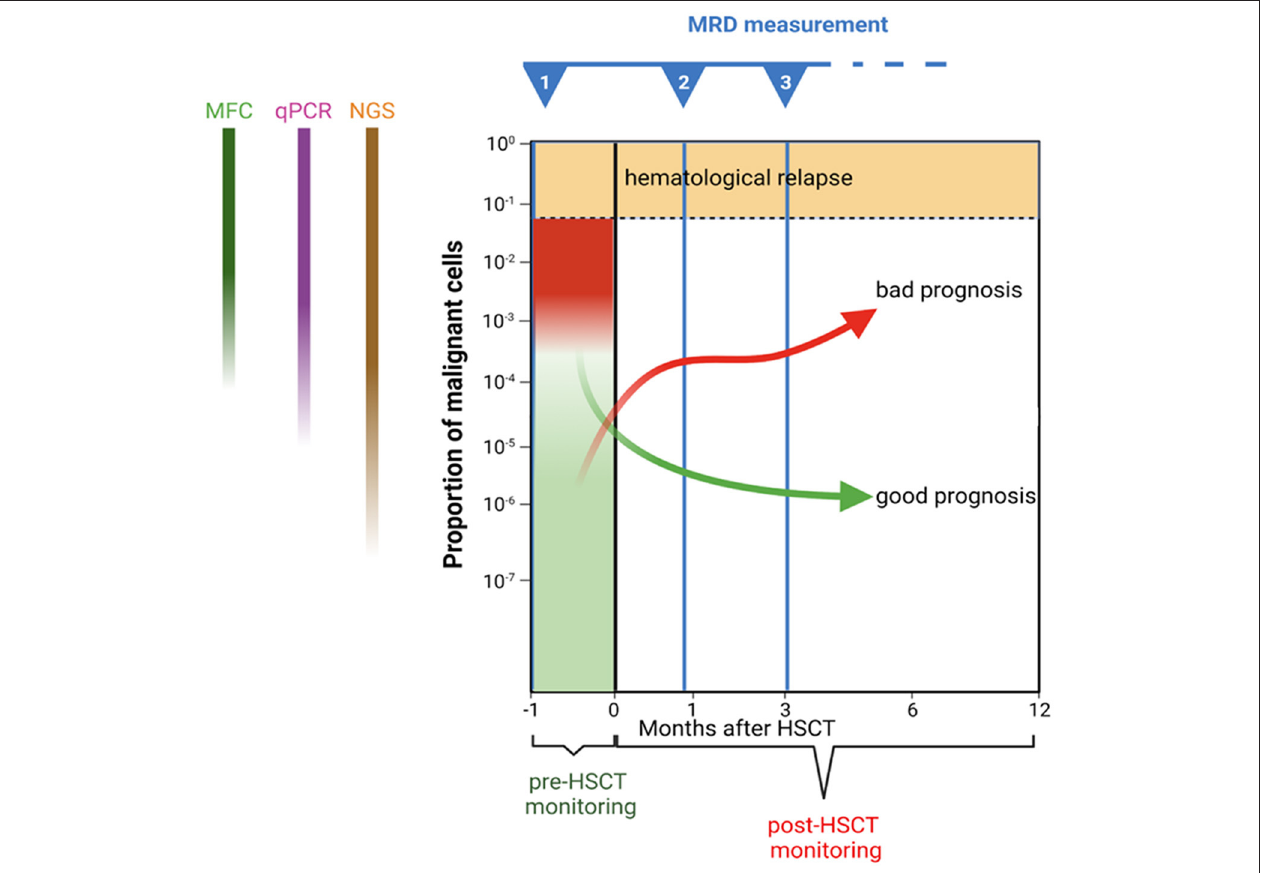
FIGURE 1 | Schematic representation of minimal residual disease monitoring before and after haematopoietic stem cell transplantation. Trajectories of hypothetical patients with different prognoses are presented as